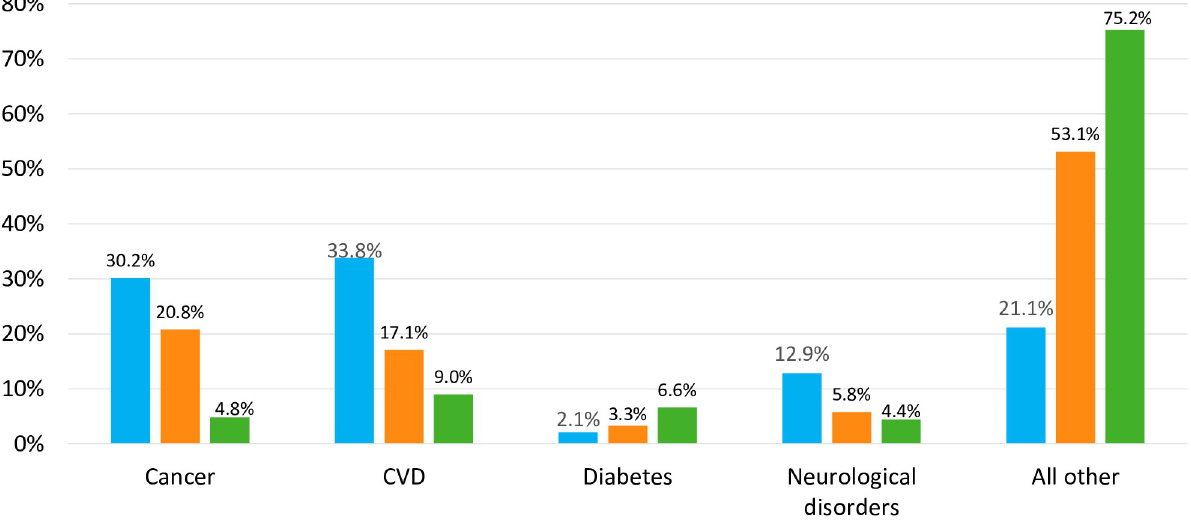
Fig 3. Average proportion of mortality, DALYs and healthcare expenditure, by disease (2015).